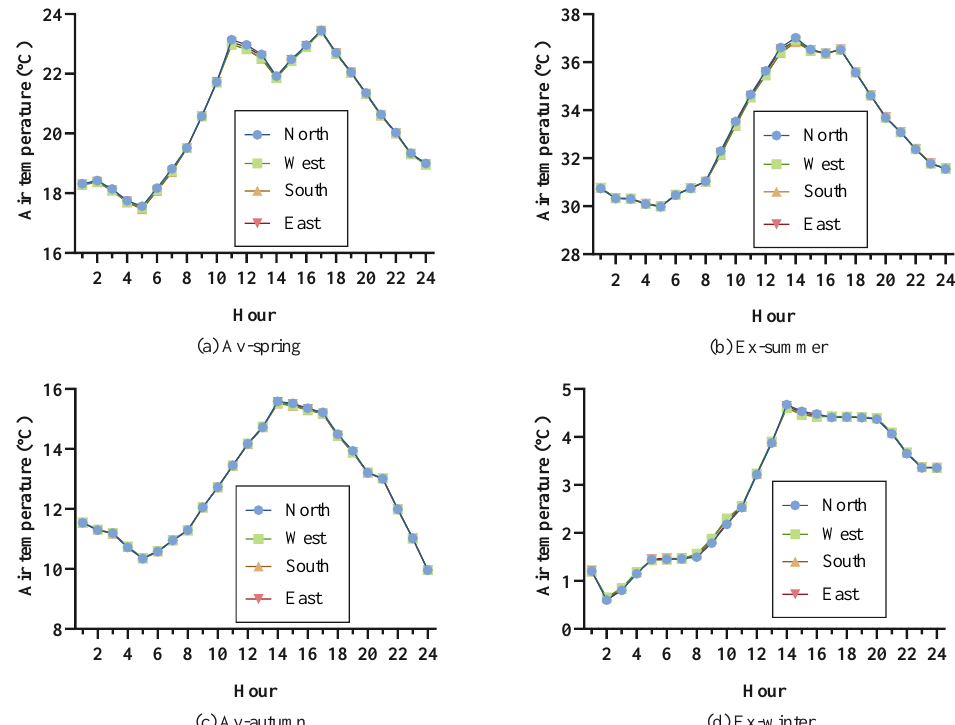
Figure 14. Air temperature of the four orientations at the height of 3 m for the four representative days.